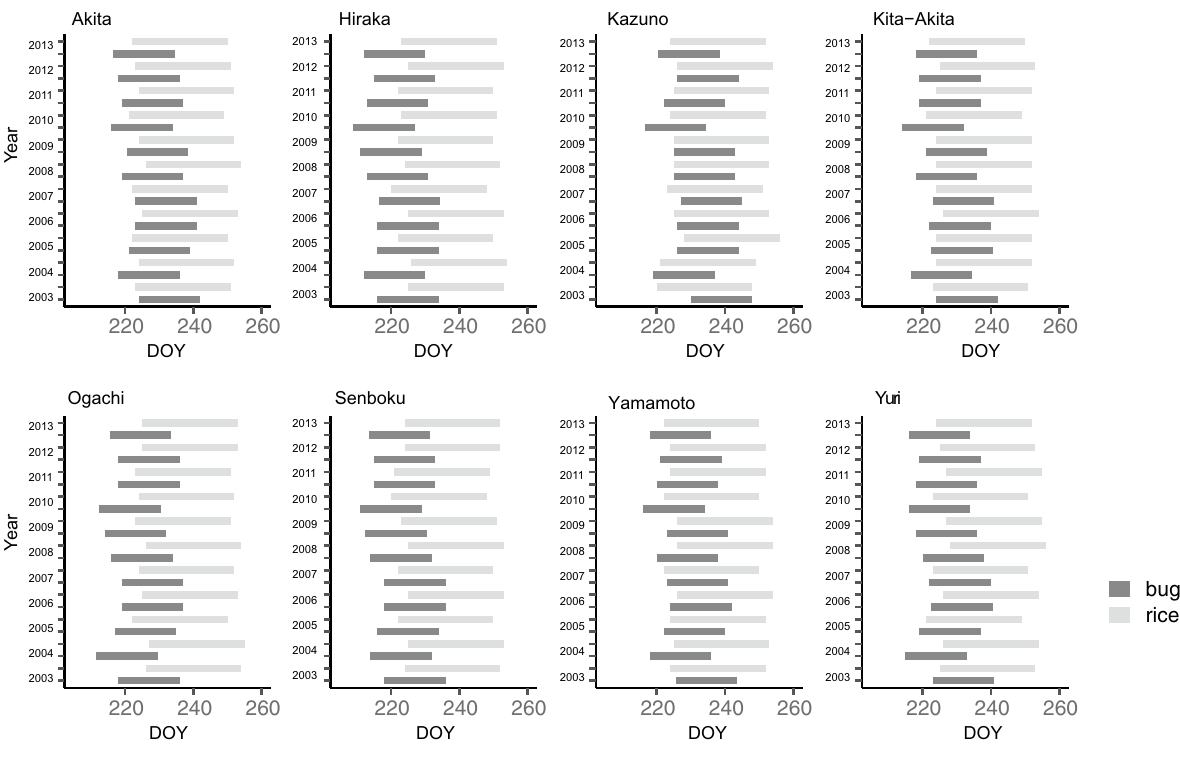
Figure 5. The overlap between the vulnerable term of rice (16 days in total, from 7 to 23 days after the median date of ear emergence) and the attacking term of S. rubrovittatus (the adult stage in the second generation) for each year in each region. X axis indicates DOY means “Day of Year” which is continuous number from 1 (1, Jan) to 365 or 366 (31, Dec).